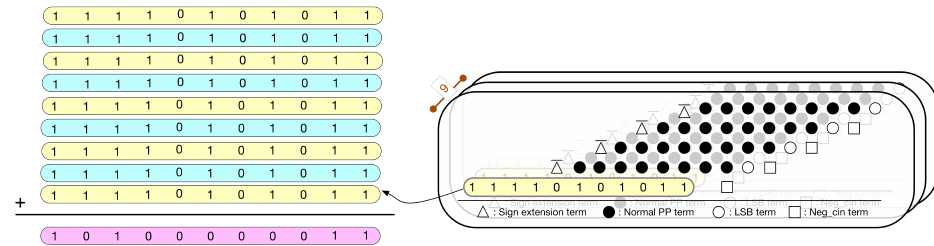
Figure 12. Pre-compute the sum of the constants of 9 PPMs.